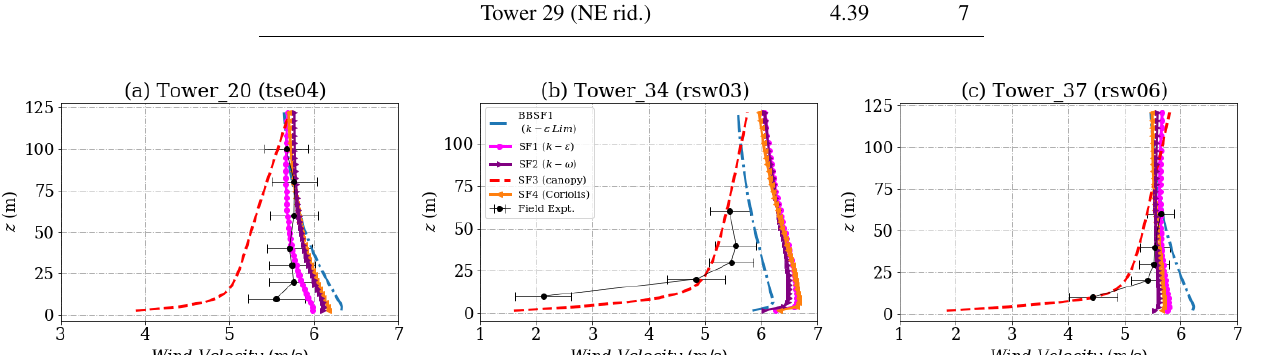
Figure 6. Simulation results and experimental data for wind velocity on the southwest ridge for (a) Tower 20 (tse04), (b) Tower 34 (rsw03) and (c) Tower 37 (rsw06). The locations of the masts are given in Fig. 2.